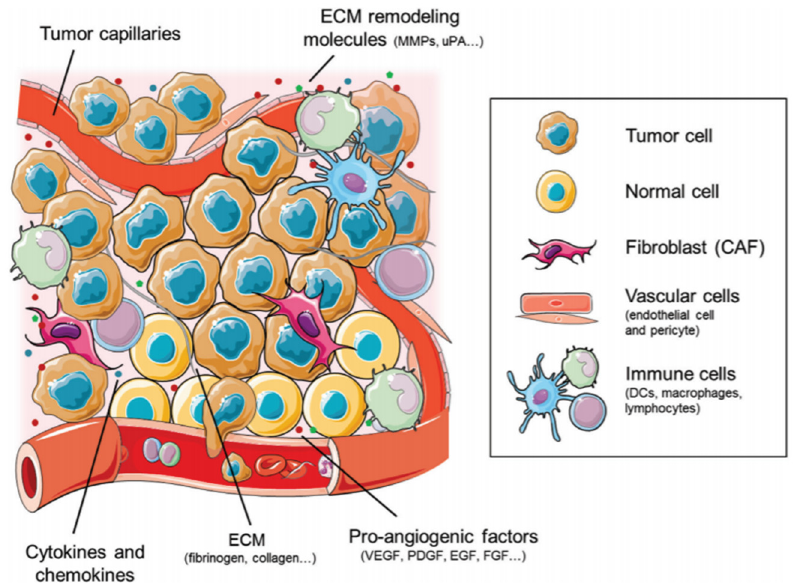
Figure 1. A closer look at the cellular and molecular components of the tumor microenvironment from the immune cells and chemokines to the extracellular matrix and their associated remodeling molecules that shape the interplay between tumor cells and host immune cells along with pro-angiogenic factors, highlighting the potential targets for therapy [49].